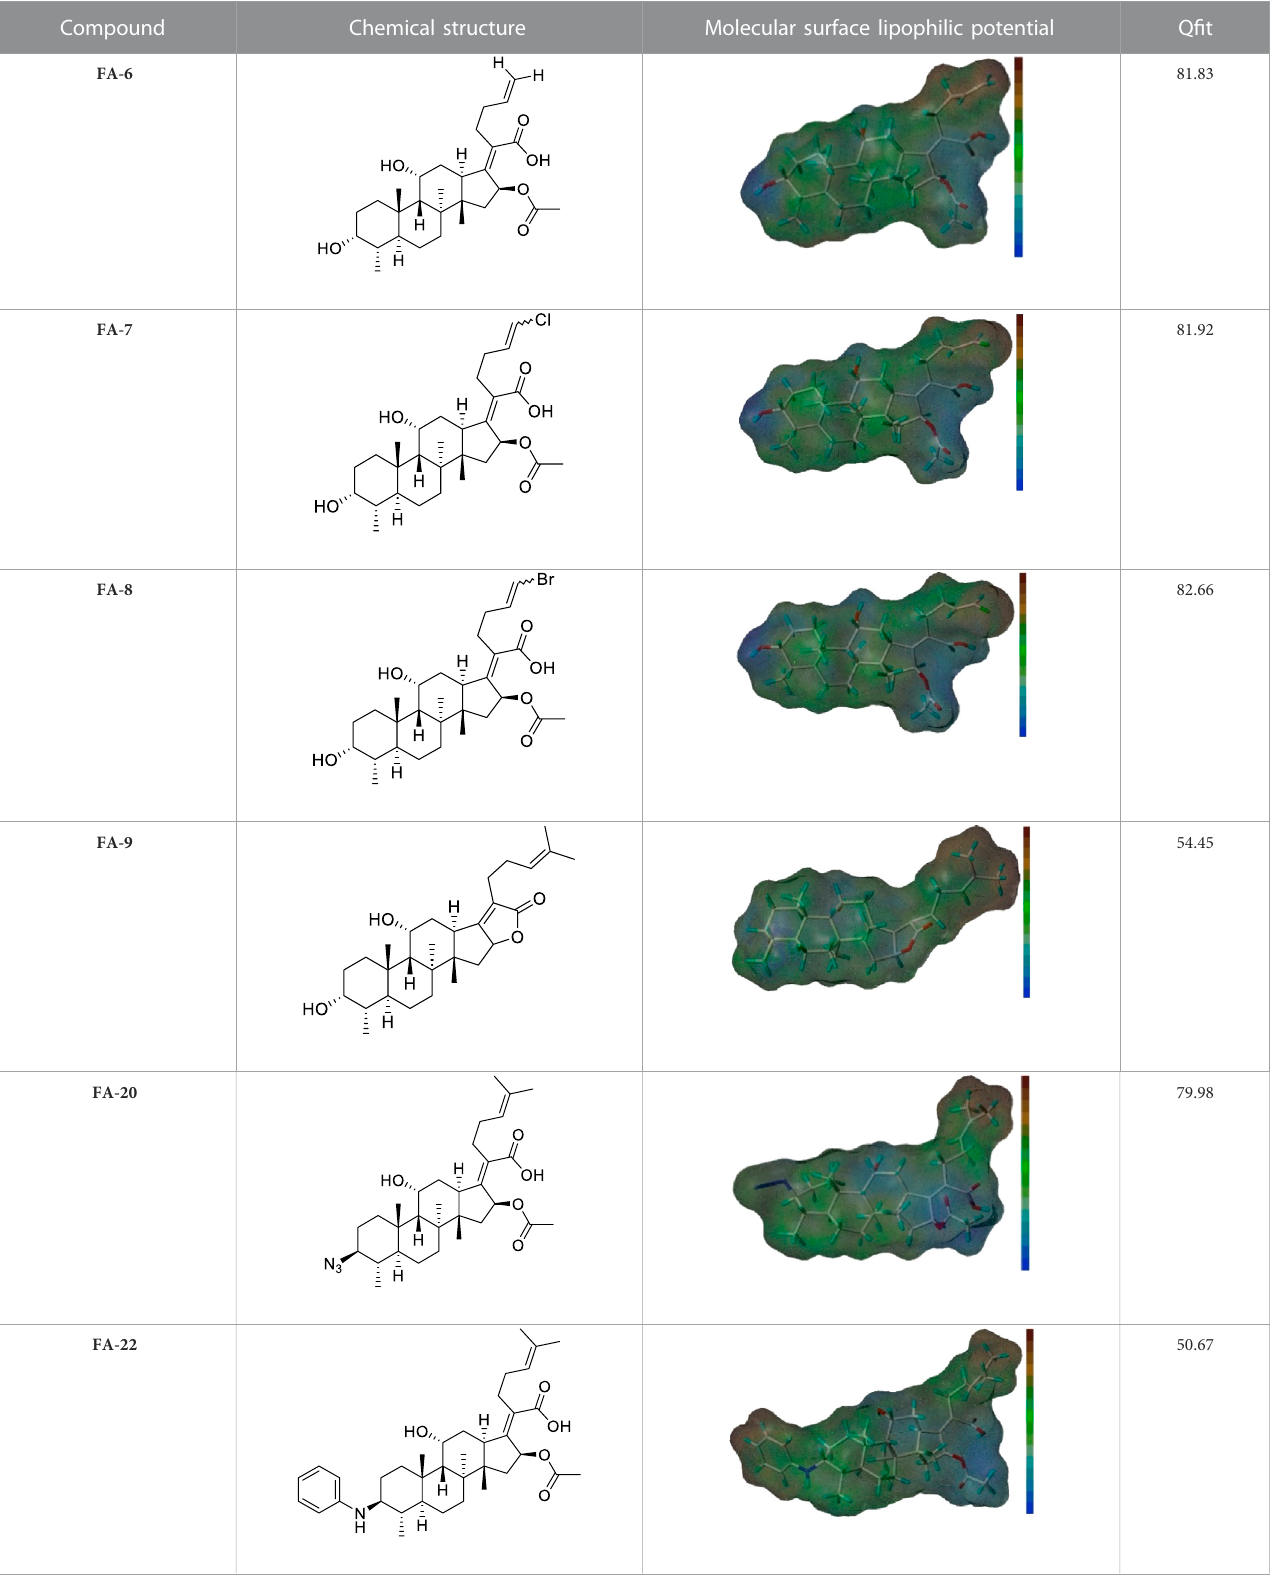
TABLE 2 Structure of the designed derivatives and the Q fi t values.